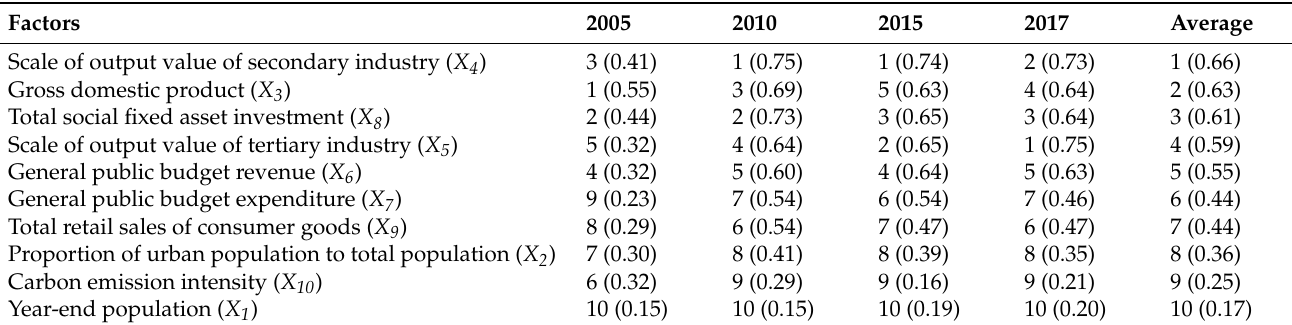
Table 5. Rank change in importance of influencing factors of carbon